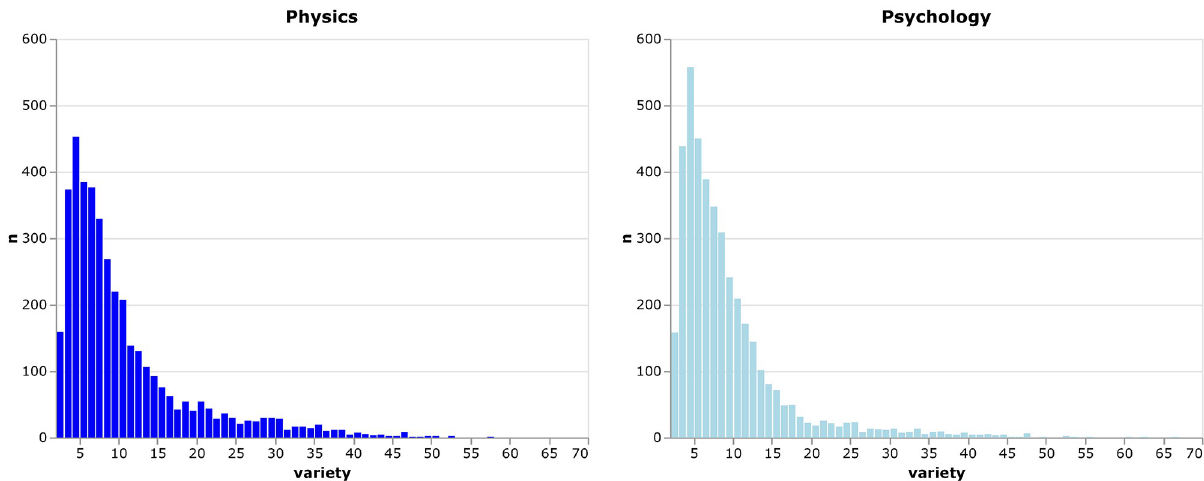
Fig 2. Distribution of variety. Distribution of the variety of early career researchers’ publications in physics and psychology, respectively.